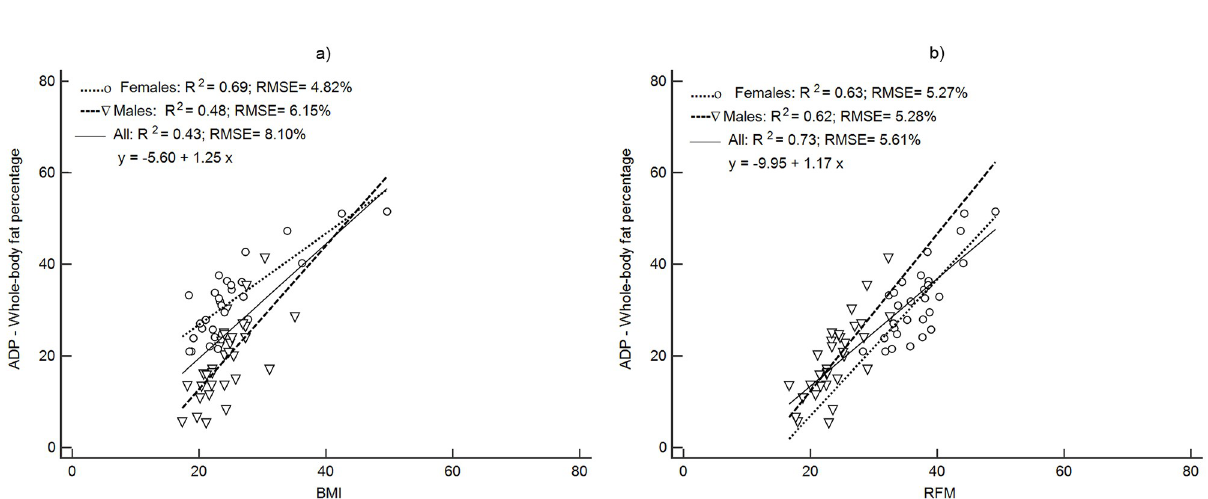
Fig 2. Prediction of FM% from BMI and RFM using ADP as a body composition method. Abbreviations: ADP, air displacement plethysmography BMI, body mass index; RFM, relative fat mass; RMSE, root mean squared